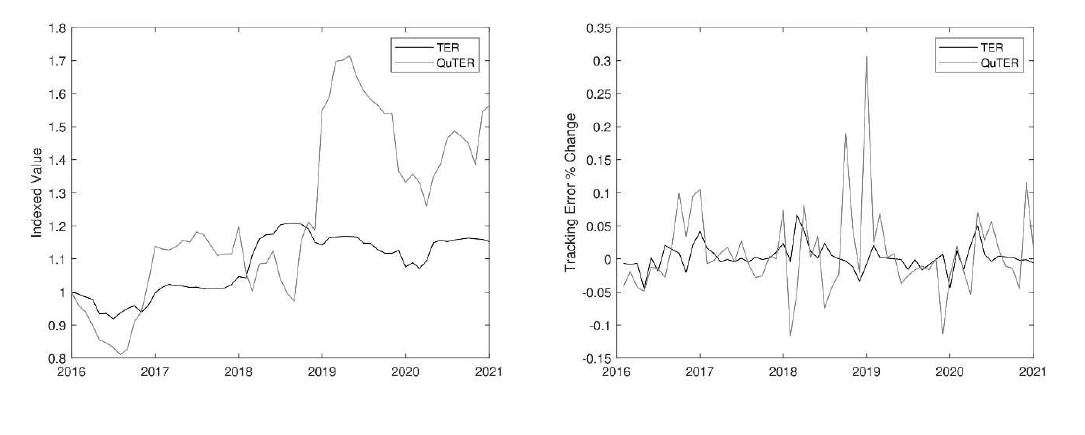
Figure 13. QuTER and TER (3-year rolling ing measures. Panel A plots the indexed value of the TER measure and the indexed value of the QuTER measure. Panel B plots the monthly per- cent change of the calculated rolling TER and QuTER measures. All differences in moments were computed over 3-year rolling windows. The sample period is from January 2013 to June 2021.